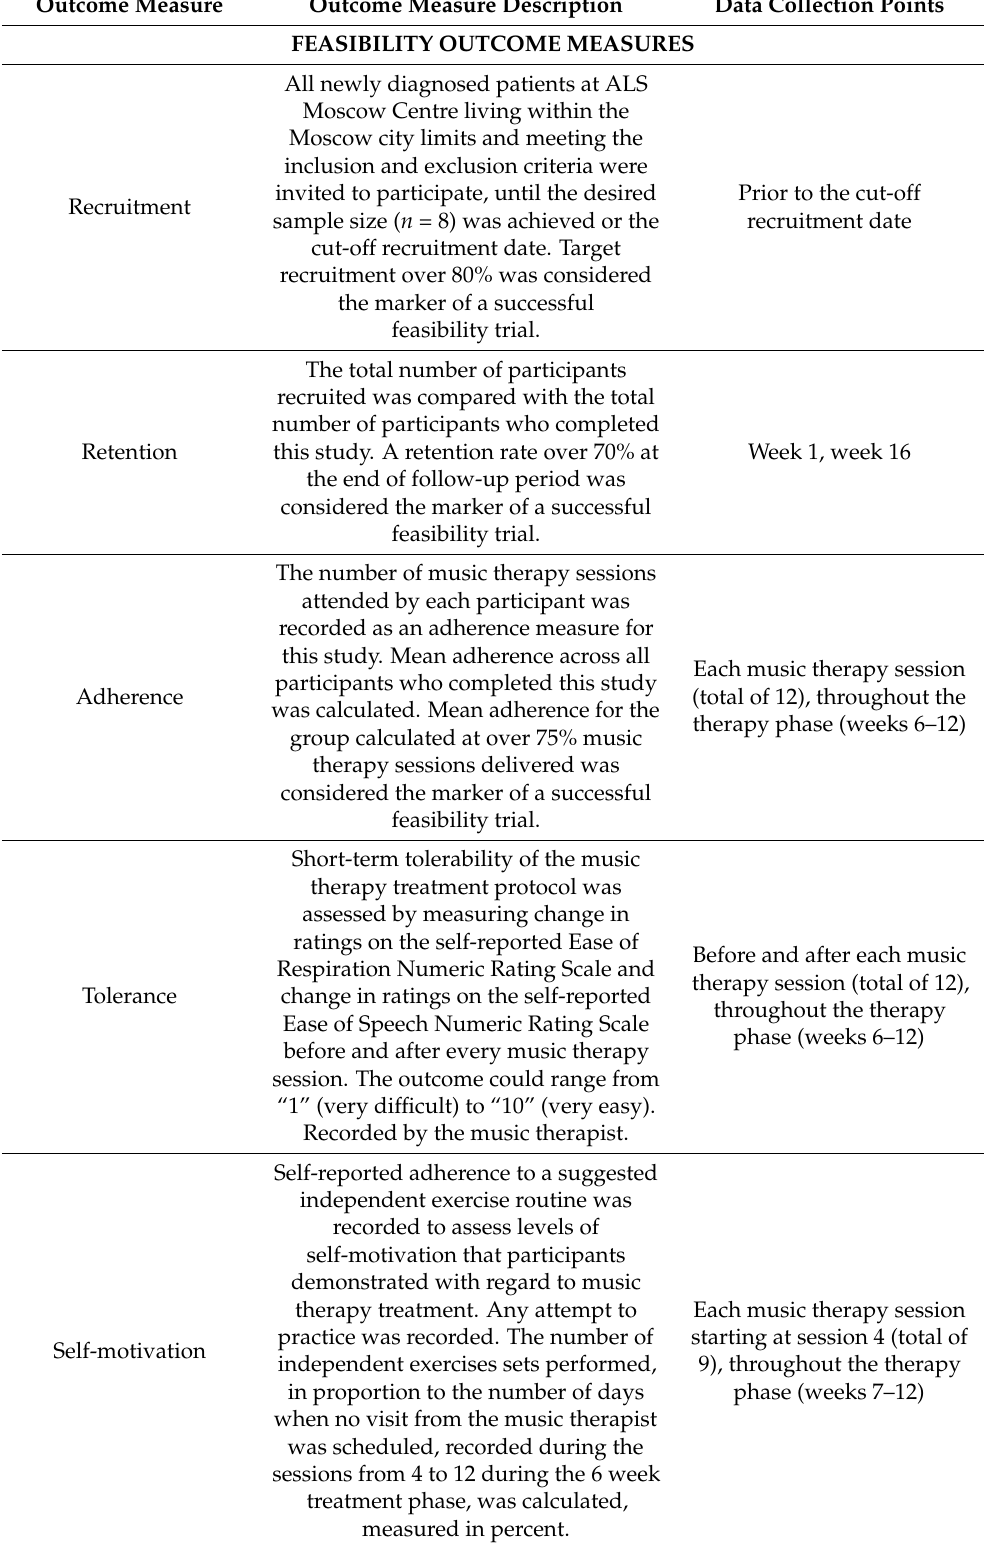
Table 2. Outcome measures and data collection summary